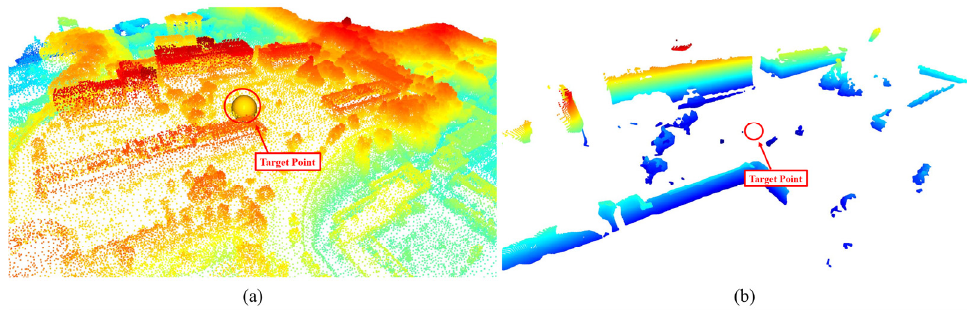
Figure 10. ( a ) Point cloud of the study area, and ( b ) intersection points obtained as a result of ray cast- ing.